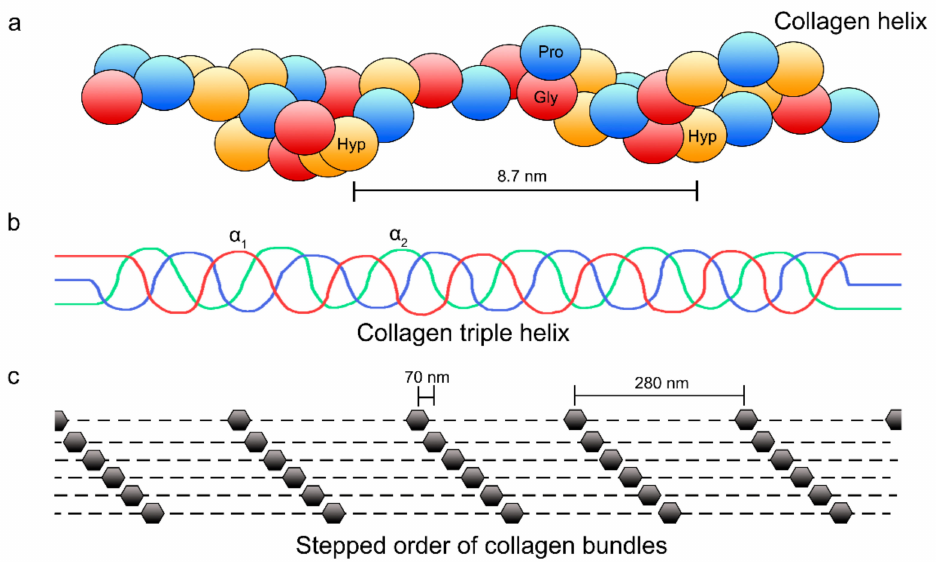
Figure 2. Each collagen helix (levorotatory strands referred as α chains) exhibits 3 residues of hydroxyproline (Hyp) (red marks), proline (Pro) (blue marks), and glycine (Gly) (yellow marks) sequences per turn ( a ). Three α chains form a quaternary structure that consists of a dextrorotatory helix ( b ). The collagen molecules gap zones are shown in ( c ), which unveil the typical staggered pattern of collagen fibrils due to the characteristic D- periodicity (67